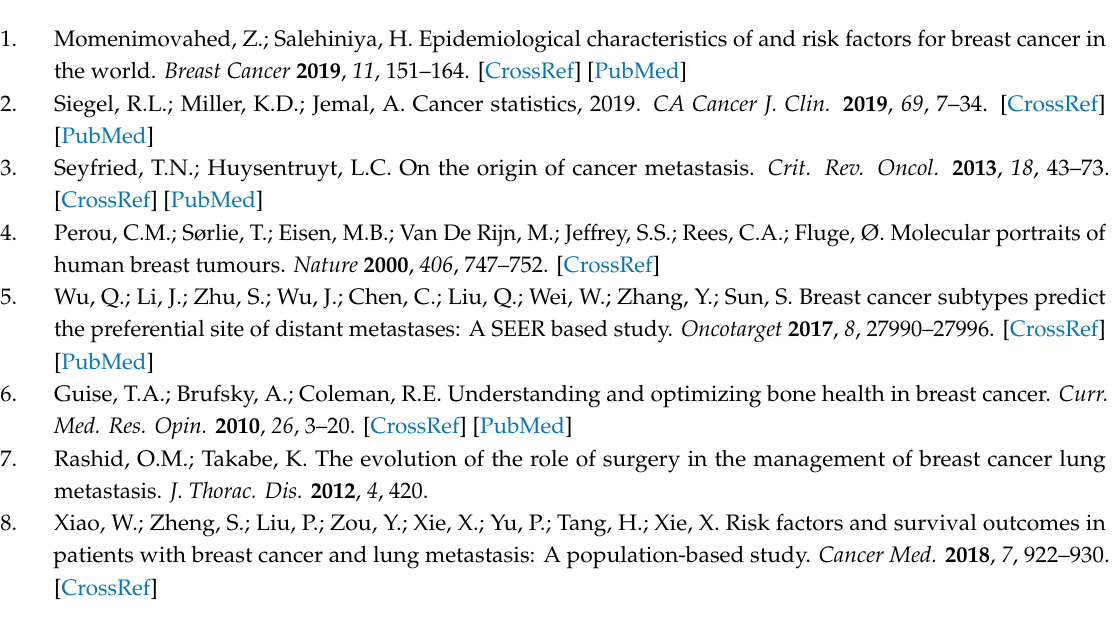
Figure S1: In vivo primary tumor growth of MCF7 and SUM159 breast cancer cells. Figure S2: Flow cytometry analysis of murine CD117 + bone marrow cells in mice bearing MCF7 or SUM159 primary breast tumors. Figure S3: Lung-conditioned media (LCM) generated from the lungs of mice bearing triple-negative SUM159 primary tumors contains metastasis-associated proteins. Figure S4: Characterization of breast cancer-derived extracellular vesicles (EVs). Table S1: Protein Array Analysis of Lung-Conditioned Media ( n = 3 per group). Table S2: Proteins unique to lung-conditioned media (LCM) generated from the lungs of mice bearing triple-negative SUM159 primary tumors ( n = 3). Table S3: Antibodies used for immunohistochemistry (IHC). Table S4: TaqMan probes used to evaluate the relative mRNA expression of murine ECM and e ff ector genes in lung tissue or human ECM genes in normal human lung fibroblasts. Table S5: Antibodies used for